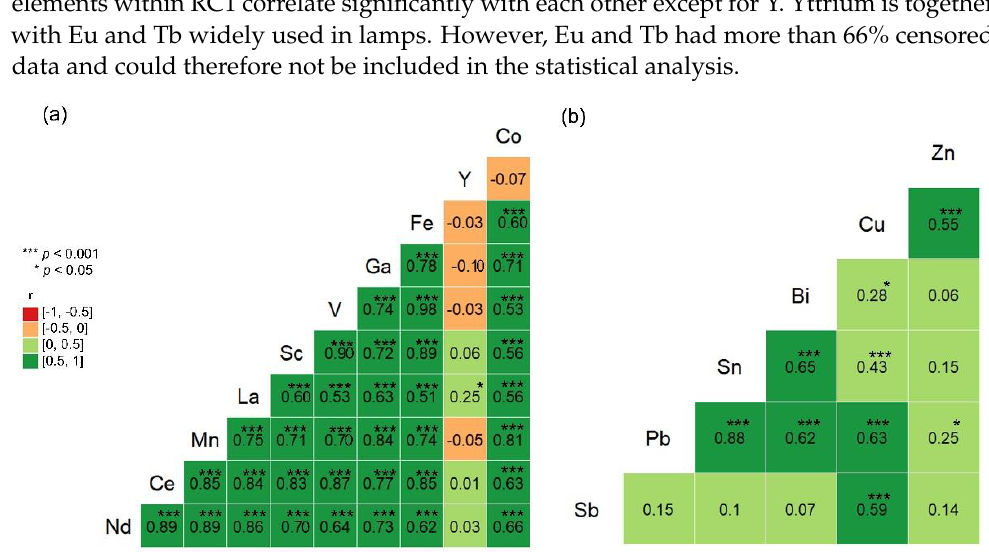
Table 2. Rank principal component analysis with varimax rotation.